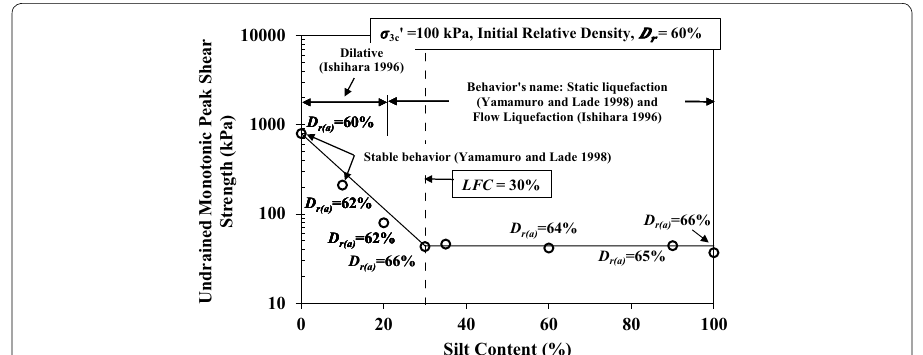
Fig. 17 Effect of silt content on undrained monotonic peak shear strength of sand–silt mixtures at Canstant initial relative density of 60%